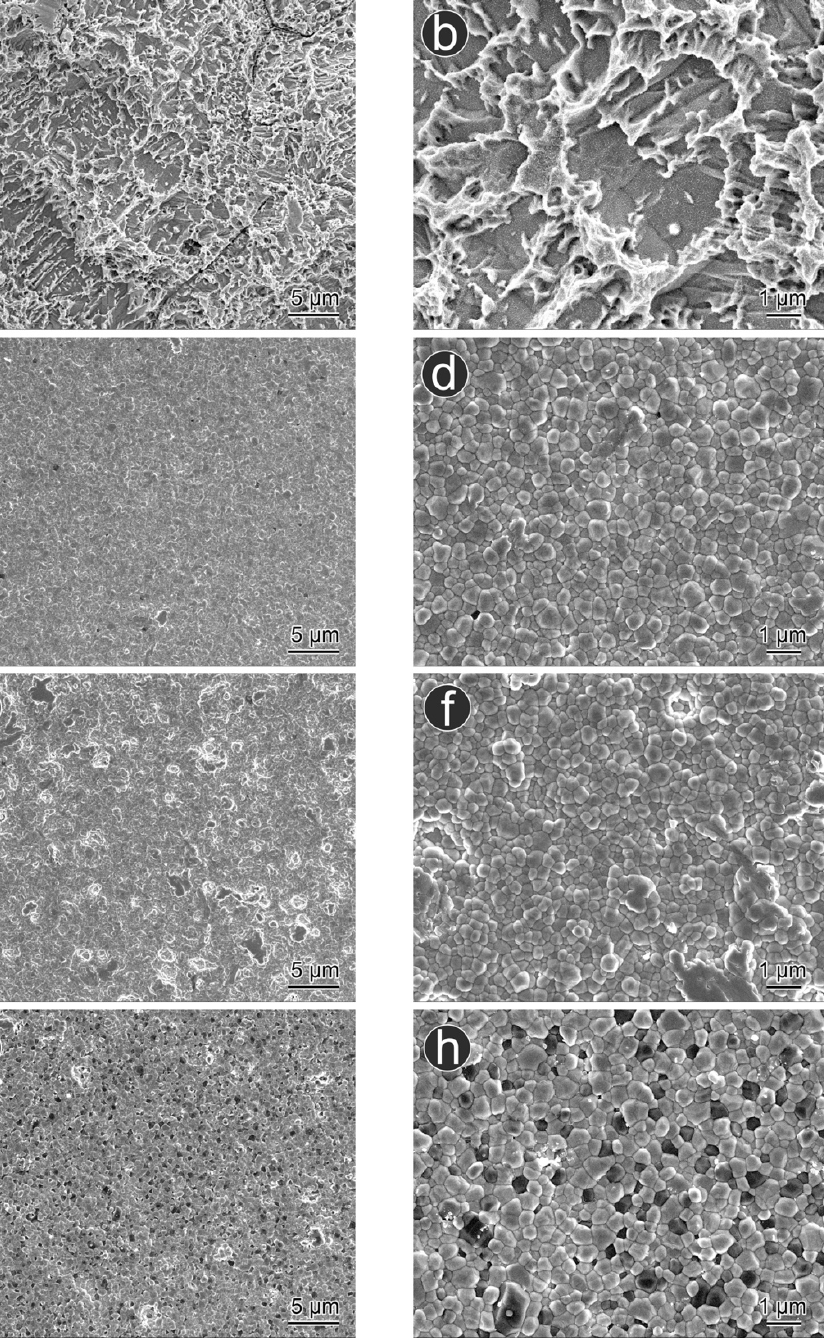
Figure 2. Representative scanning electron microscopy (SEM) images: ( a , b ) sandblasted (large-grit) and acid-etched titanium (SLA-titanium), ( c , d ) uniaxially pressed zirconia (UP zirconia), ( e , f ) addi- tively manufactured zirconia (AM zirconia), and ( g , h ) additively manufactured ATZ (AM ATZ).